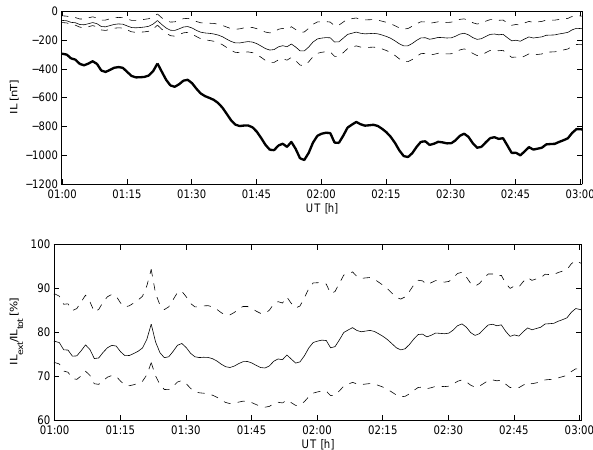
Fig. 13. Top panel: the measured total (thick solid) and the com- puted internal part of the 5-min low-pass filtered IL index for the 26 June 1998 substorm event. Bottom panel: ratio between the external IL and the total IL . Only continental IMAGE stations were used to compute the index. The dashed curves in both panels correspond to fields computed with conductivities 10 − 1 S/m (lower curve) and 10 − 3 S/m (upper curve), respectively. See the text for